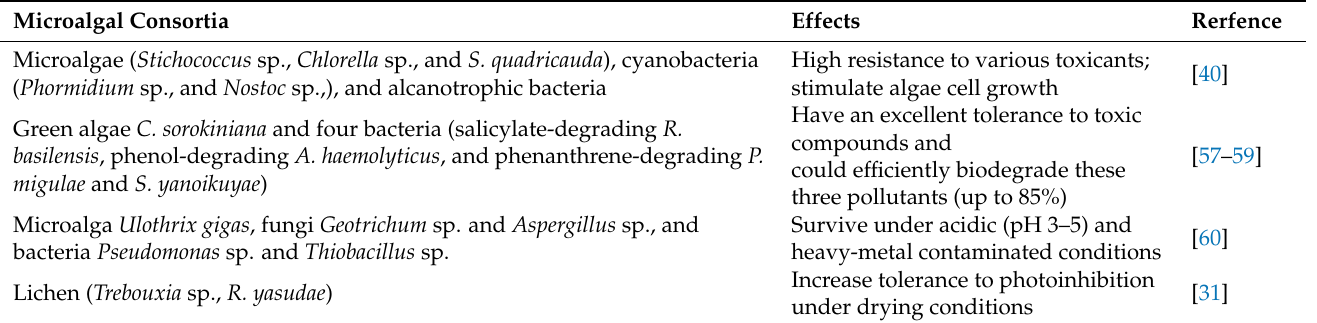
Table 2. Stress resilience and tolerance enhanced in microalgal consortia. Microalgal Consortia Effects Rerfence Microalgae ( Stichococcus sp., Chlorella sp., and S. quadricauda ), cyanobacteria High resistance to various ( Phormidium sp., and Nostoc sp.,), and alcanotrophic bacteria